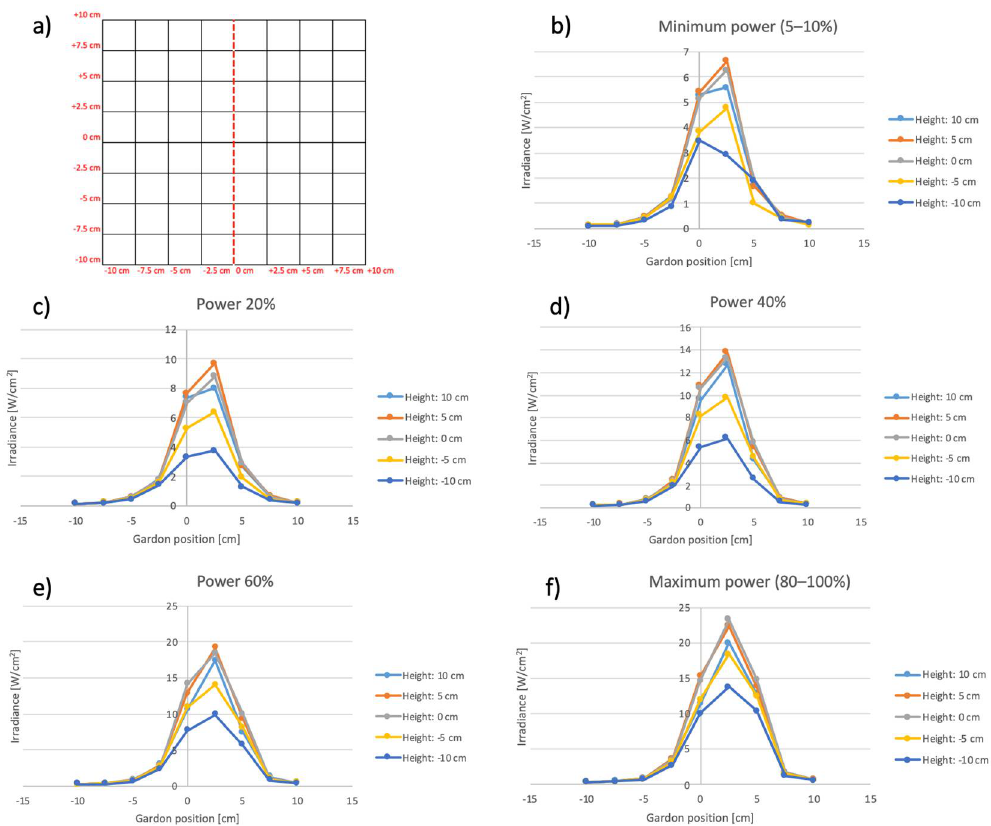
Figure 14. Irradiance along the horizontal central line (0 cm) highlighted in ( a ), for several heights of the workbench; all graphs are related to the lamp #7; ( b ) electrical power of lamp 5–10%; ( c ) electrical power of lamp 20%; ( d ) electrical power of lamp 40%; ( e ) electrical power of lamp 60%; ( f ) electrical power of lamp 80–100%.